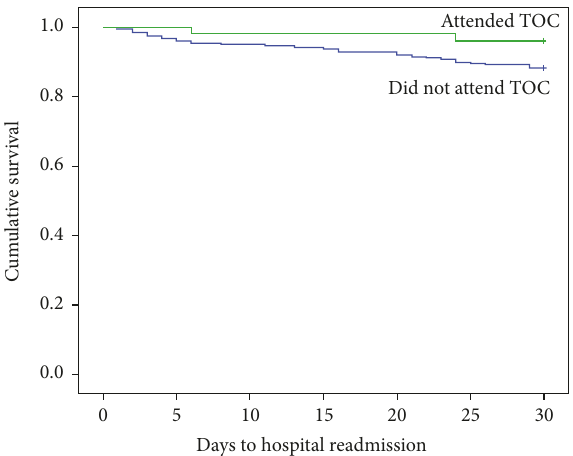
Figure 1: Kaplan-Meier plot comparing 30-day readmission rates between patients who did or did not attend the transition of care